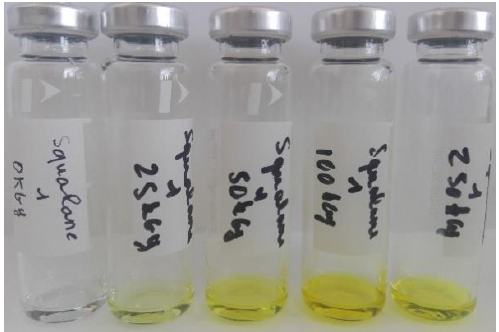
Figure 3. Non-irradiated and γ-irradiated 2,6-di-tert-butyl-p-cresol in polymer matrix simulating (left to right: 0, 25, 50, 100, and 250 kGy) .